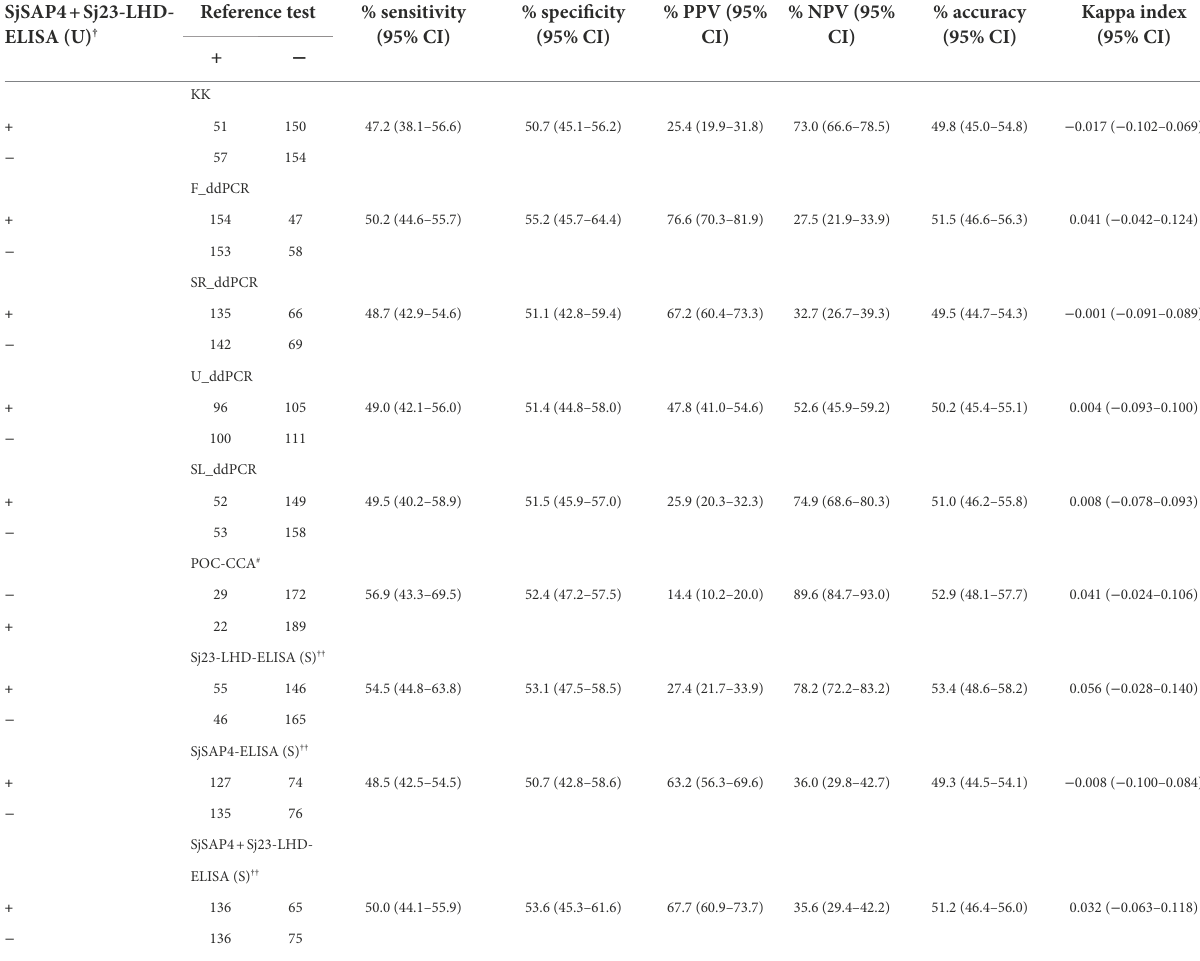
TABLE 2 Diagnostic performance of the urine ELISA assay using different tests as reference. SjSAP4 + Sj23-LHD- ELISA (U)